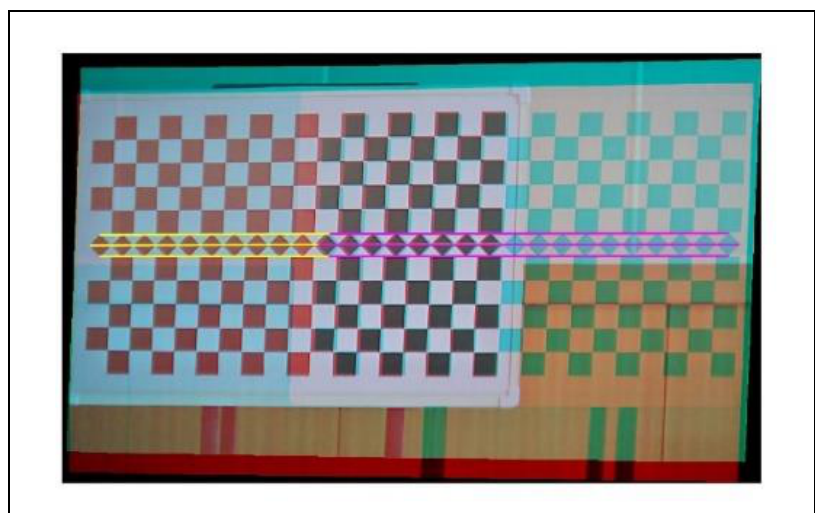
Figure 20. Lines that connect the diamond vertex on the rectified image.